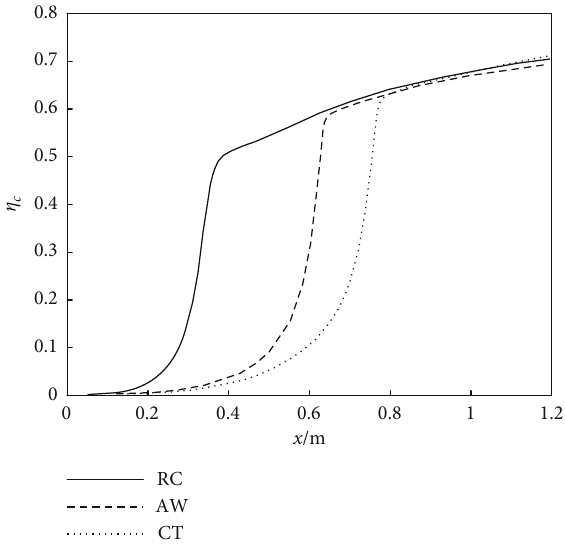
Figure 16: Combustion e ffi ciency distributions along the combustor